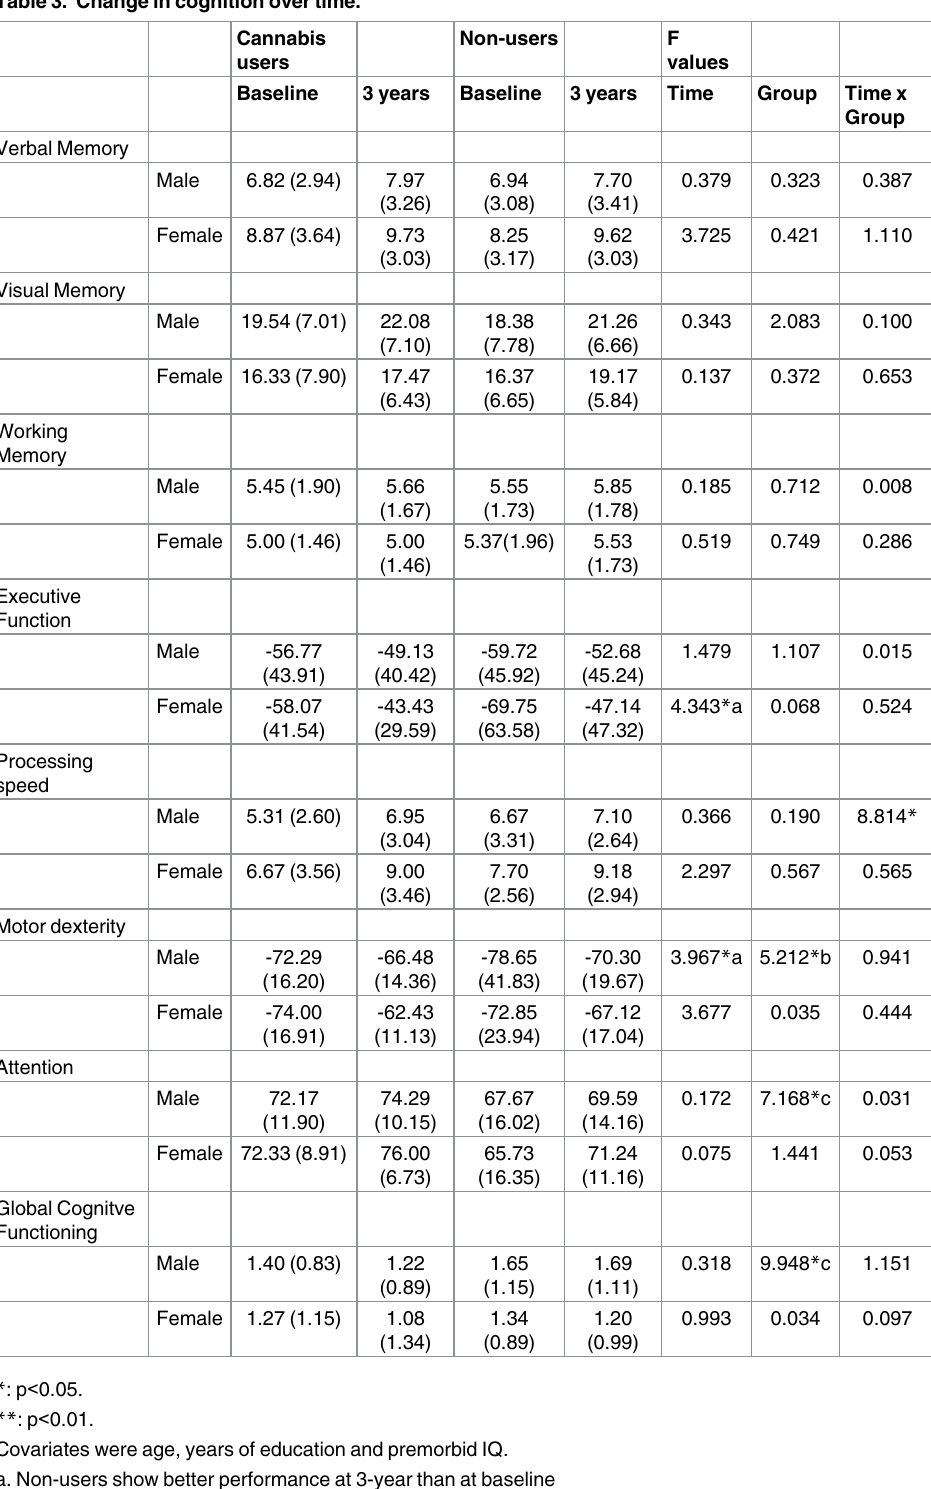
Table 3. Change in cognition over